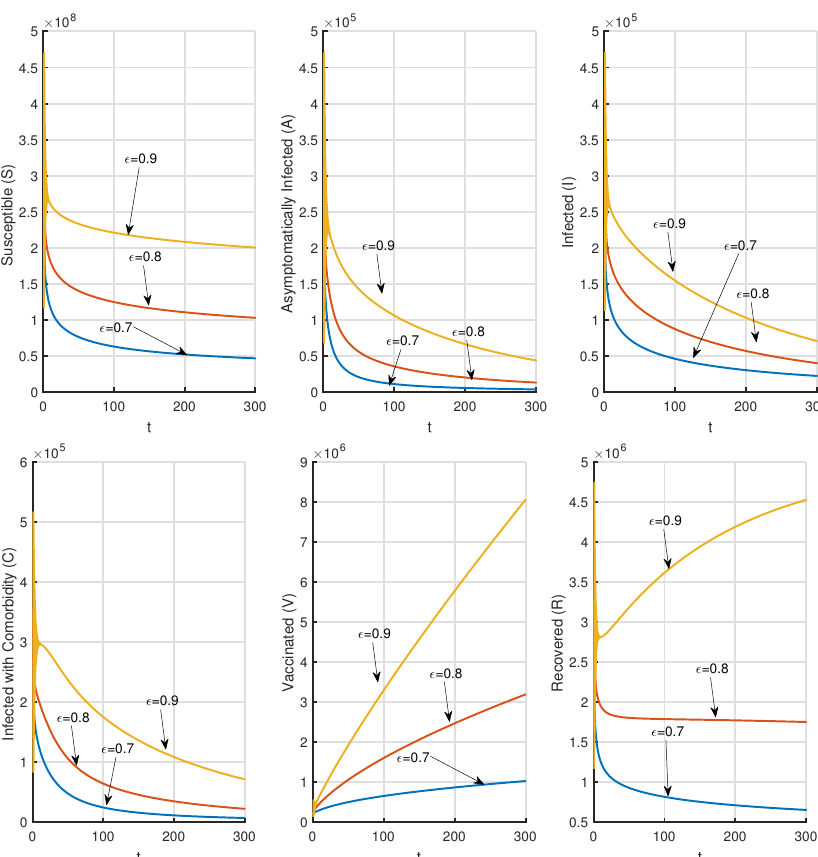
Figure 10. Variation of time series of all state variables for t = 300 days when ε = 0.7,0.8,0.9.